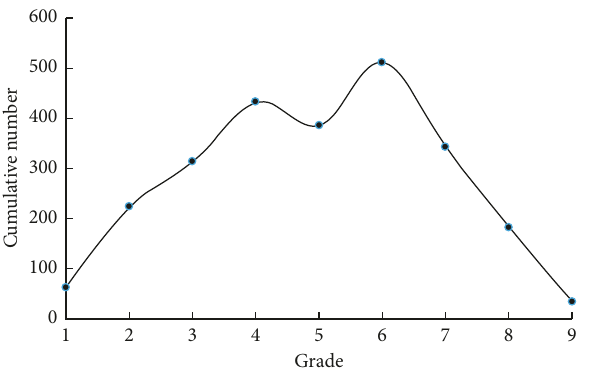
Figure 5: Data distribution of evaluation results.